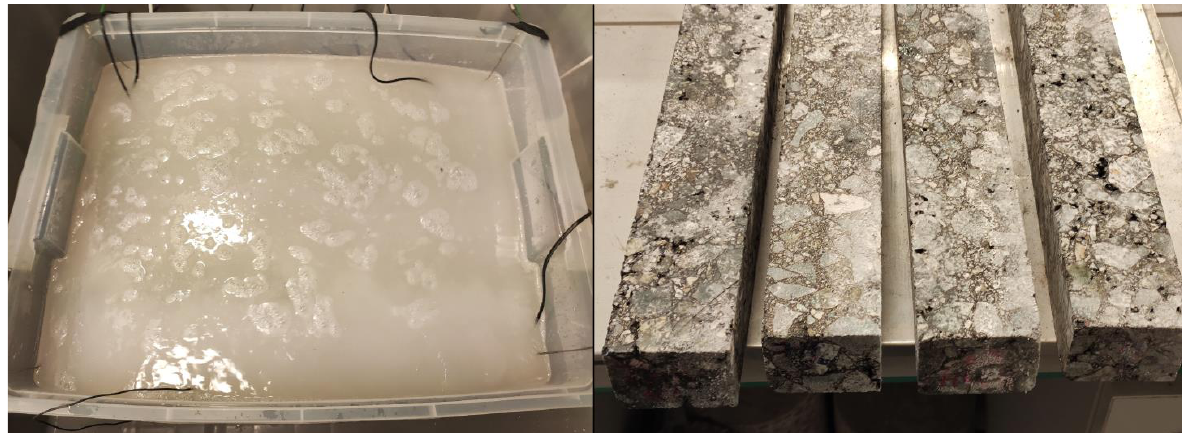
Figure 6. Brine system and specimens after